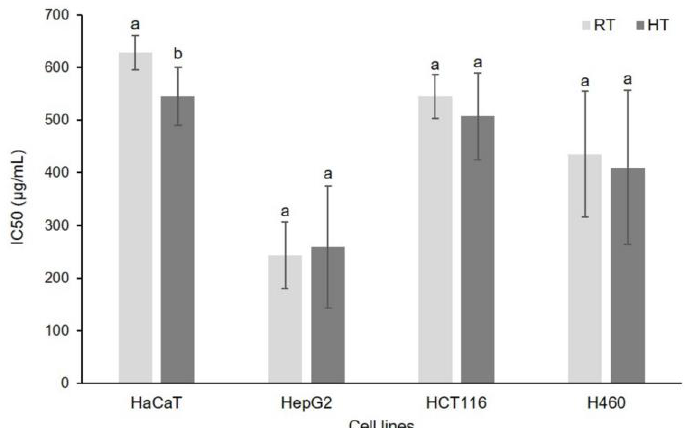
Figure 1. MTT assay showing the viability, expressed in IC50 values, of HaCaT, HepG2, HCT116, and H460 cells after exposure to the extracts of broccoli seedlings grown under room (RT) and high temperature (HT). Values represent mean ± standard deviation of three biological replicates and three technical replicas. Different letters indicate a significant difference among the values for each cell type separately (ANOVA, Duncan ’s test, p ≤ 0.05). HaCaT = normal human keratinocytes, HepG2 = hepatocellular carcinoma cells, HCT116 = colorectal carcinoma cells, and H460 = lung carcinoma cells.